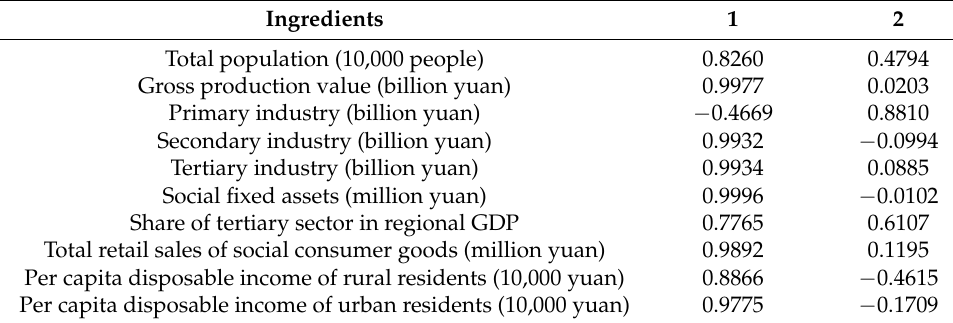
Table 3. Results of the principal component analysis.